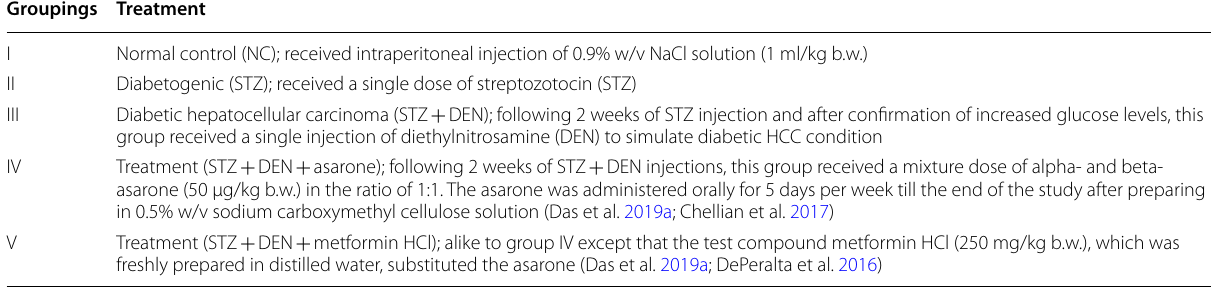
Table 1 Experimental design and treatment protocol (for a duration of 18 weeks) Groupings